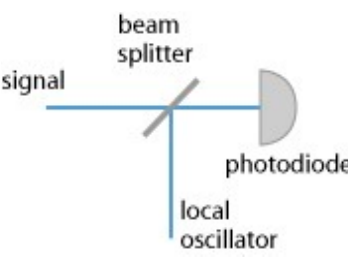
Figure 3. Heterodyne technique.